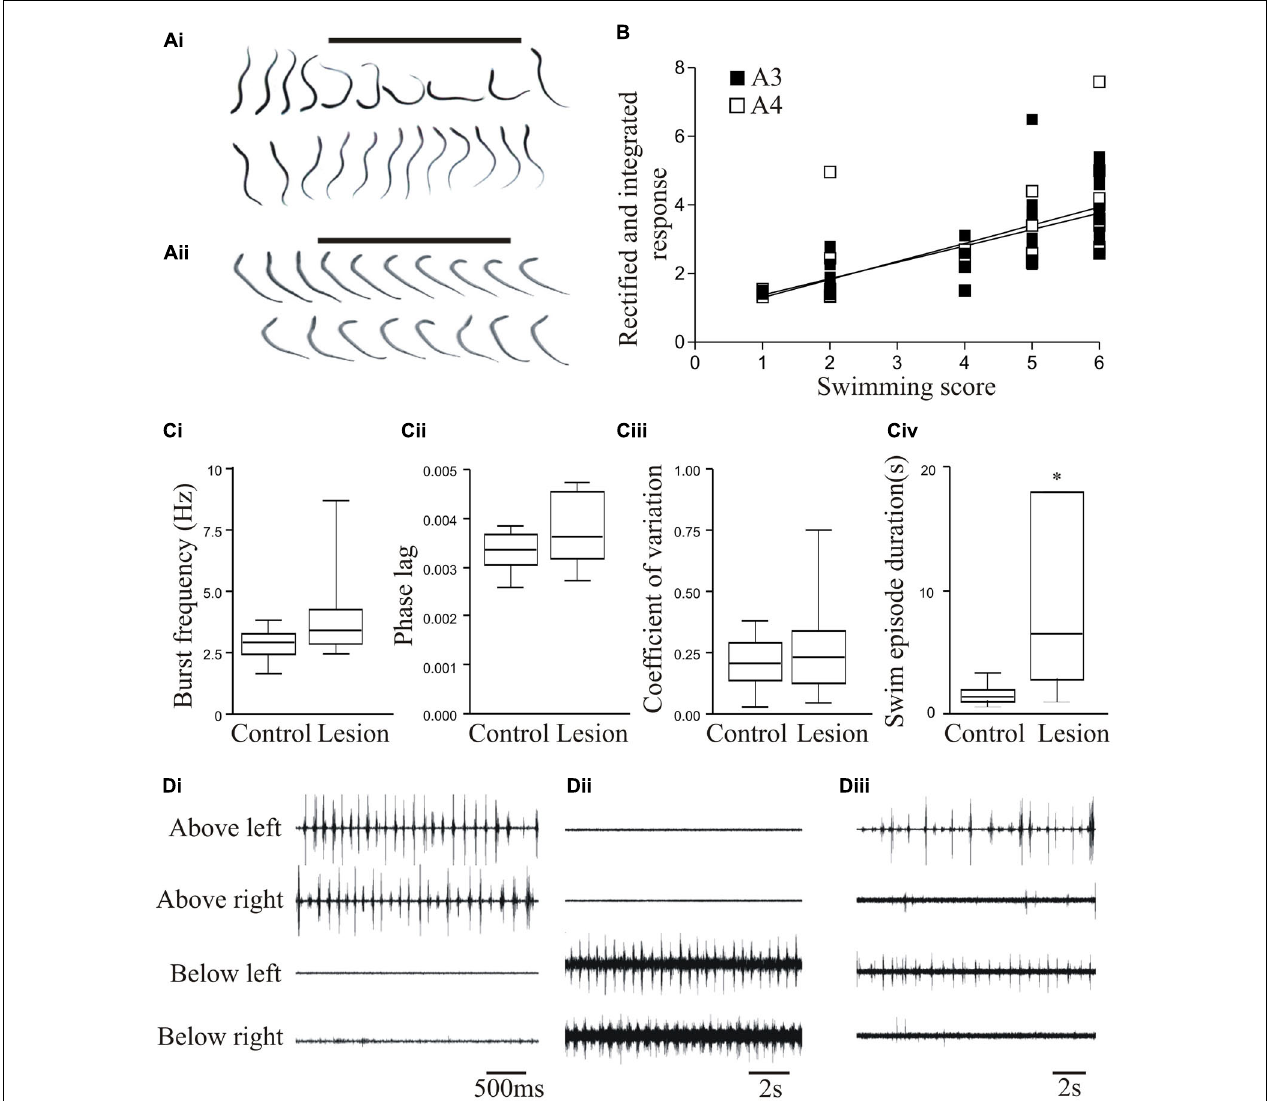
FIGURE 1 | Behavioral recovery. (Ai) Video frames from an animal that recovered good locomotor function. The bar indicates a mechanical stimulus given to the body, and shows the coordinated movement away from the stimulus. (Aii) Swimming of an animal that failed to recover. (B) Graph showing the correlation of swimming performance with the degree of regeneration, assessed from ventral root responses below the lesion site ipsilateral (A3) and contralateral (A4) to stimulation above the lesion. (Ci–Civ) Graphs comparing the swimming performance in animals that recovered well with that of unlesioned animals: the only significant difference was the duration of a swimming episode. (Di–Diii) Example of myogram activity from animals that failed to recover locomotor function. Data from Hoffman and Parker (2011). Permission granted to reproduce. ∗ Indicates statistical significance at p <